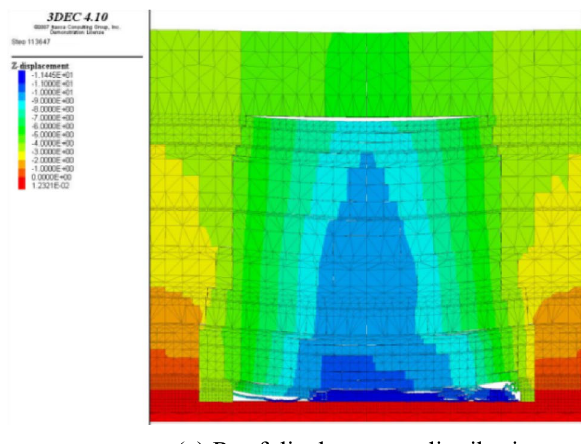
Fig. 5 Roof stratum structure simulation